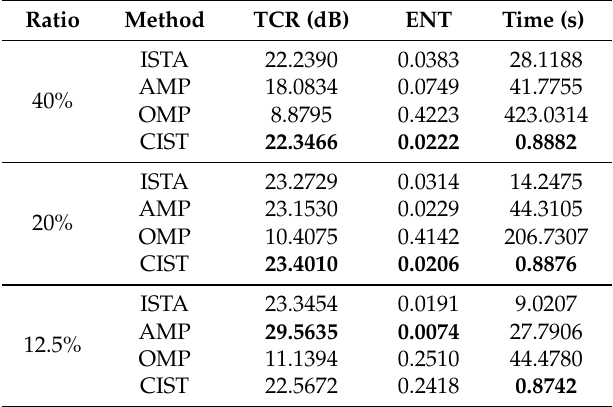
Figure 8. ISAR imaging results of data I of different methods at ratio 40%, 20% and 12.5% respectively. Table 3. Evaluation for Measured Experiments of data